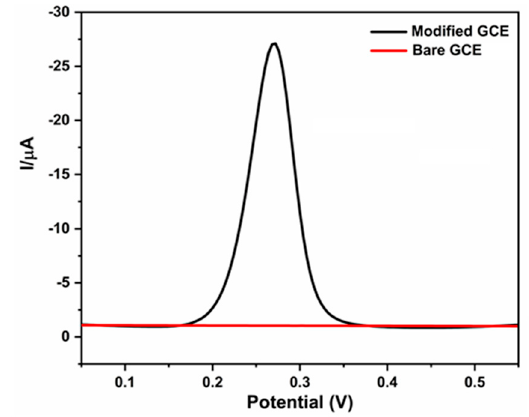
Figure 4. Di ff erential pulse voltammograms of Anti-IL8/MoS 2 /ZnO composite modi fi ed GCE elec- Figure 4. Differential pulse voltammograms of Anti-IL8/MoS 2 /ZnO composite modified GCE trodes and bare GCE concentrations of IL8 range 2000 pg. electrodes and bare GCE concentrations of IL8 range 2000